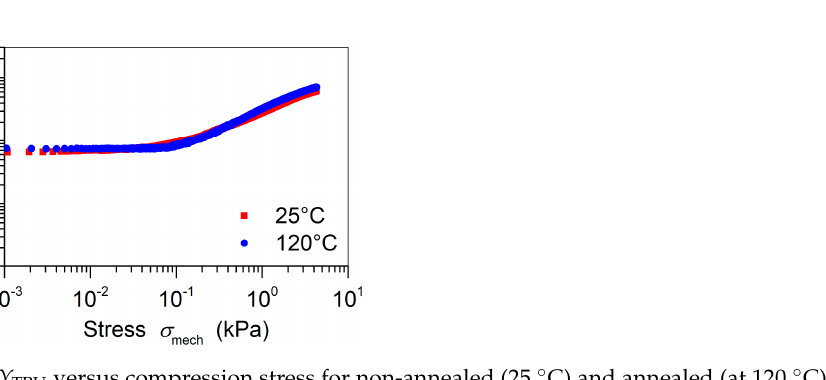
Figure 6. Y TPU versus compression stress for non-annealed (25 ◦ C) and annealed (at 120 ◦ C) solid Figure 6. 𝑌 (cid:2904)(cid:2900)(cid:2905) versus compression stress for non-annealed (25 °C) and annealed (at 120 °C) solid TPU films of 270 µ m TPU films of 270 µm thickness.